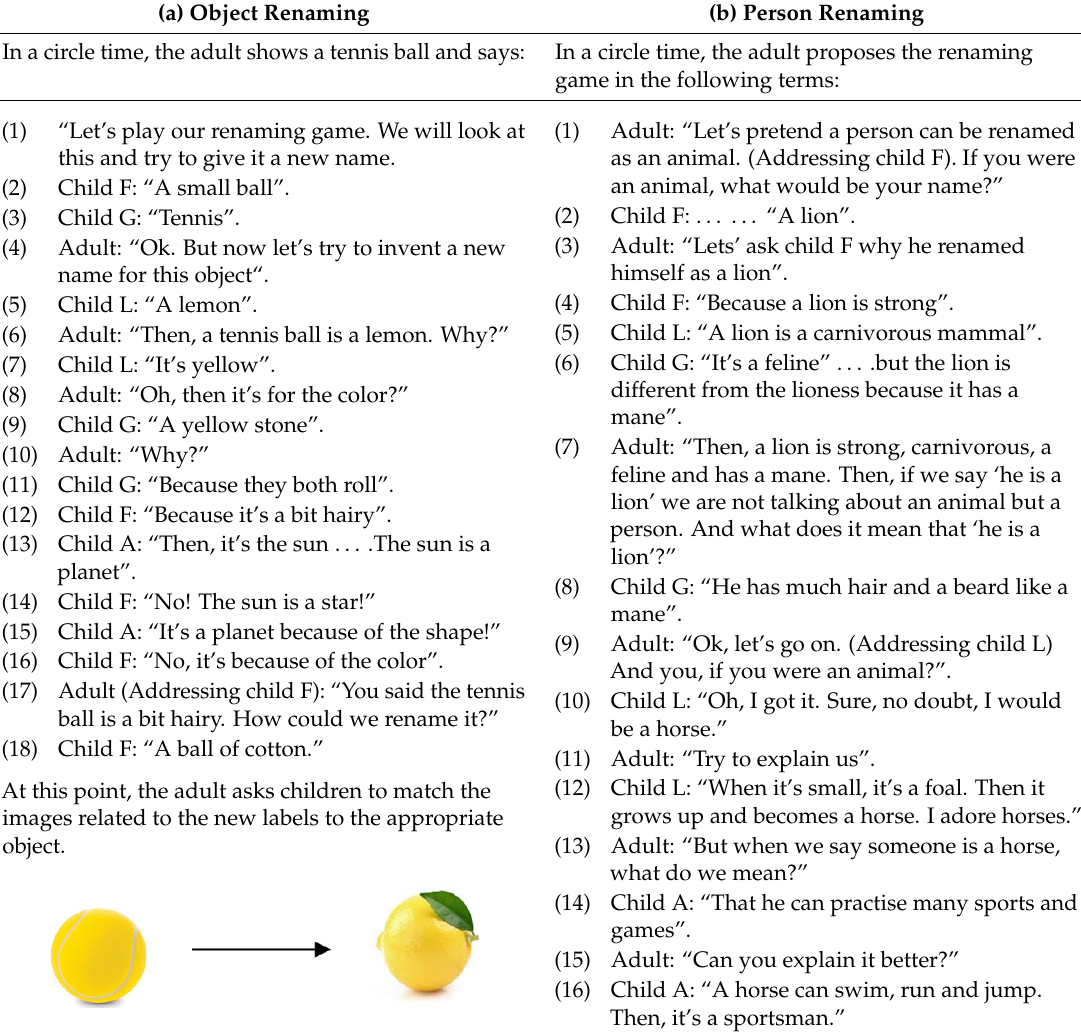
Table 3. Examples of renaming activities.